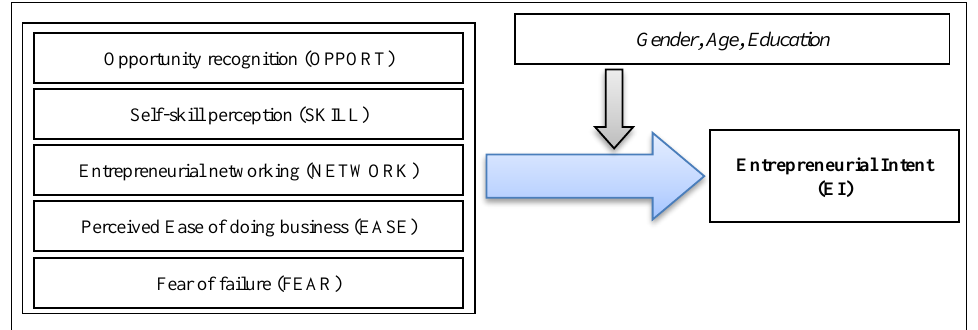
Figure 2. The Proposed Hypothesis Testing Model